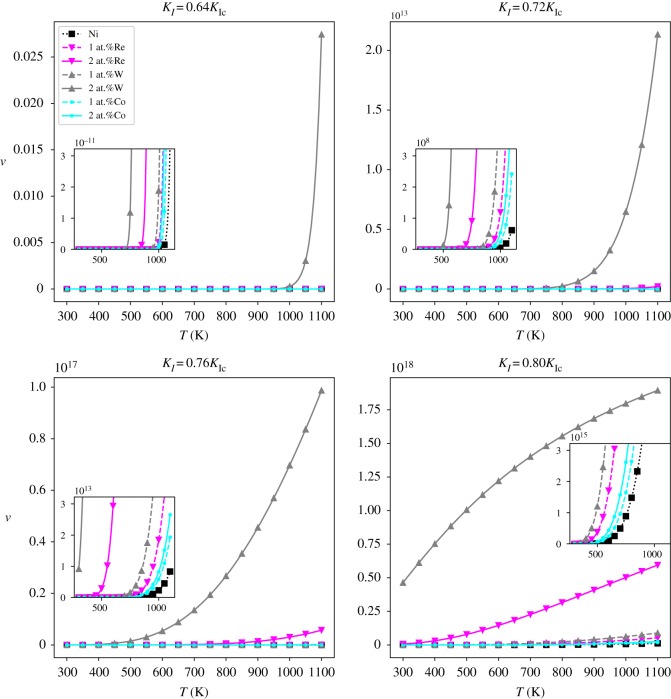
Curves of dislocation nucleation frequency (ν) versus temperature (T) at loads KI = 0.64KIc, KI = 0.72KIc, KI = 0.76KIc and KI = 0.80KIc.